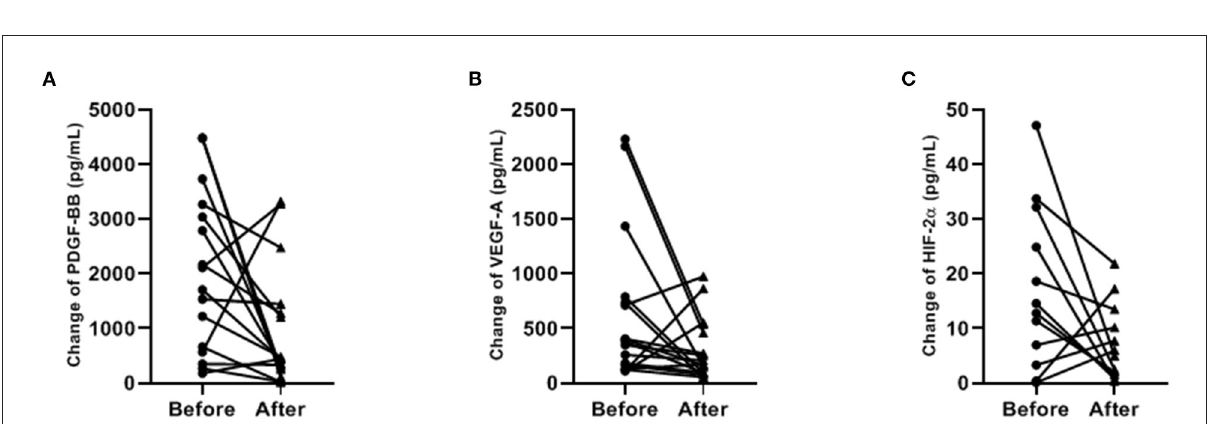
FIGURE3 Paired dot plotting of antigenic factors levels before and after ibuprofen exposure (A–C) . PDGF-BB, platelet-derived growth factor BB; VEGF-A, vascular endothelial growth factor A; HIF-2 α , hypoxia-inducible factor 2 α . Only 12 paired data were shown in (C) because the concentration of HIF-2 α was below the detection limit in the rest